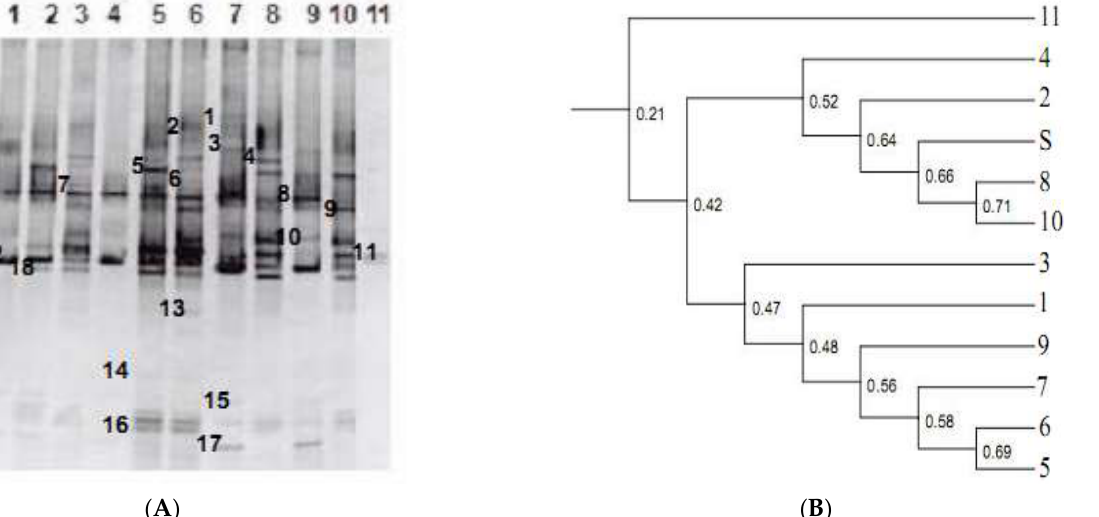
Figure 4. Denaturing gradient gel electrophoresis (DGGE) showing changes in the archaea population in the fixed-bed reactors. ( A ) Archaea bands; ( B ) Systematic trees from DGGE band analysis. S: seed sludge sample; 1, 3, 5, 7, 9: adherent sludge at 18 °C, 10 °C, 8 °C, 6 °C, and 4 °C; 2, 4, 6, 8, 10, 11: deposition sludge at 18 °C, 10 °C, 8 °C, 6 °C, 4 °C, and 3 °C.